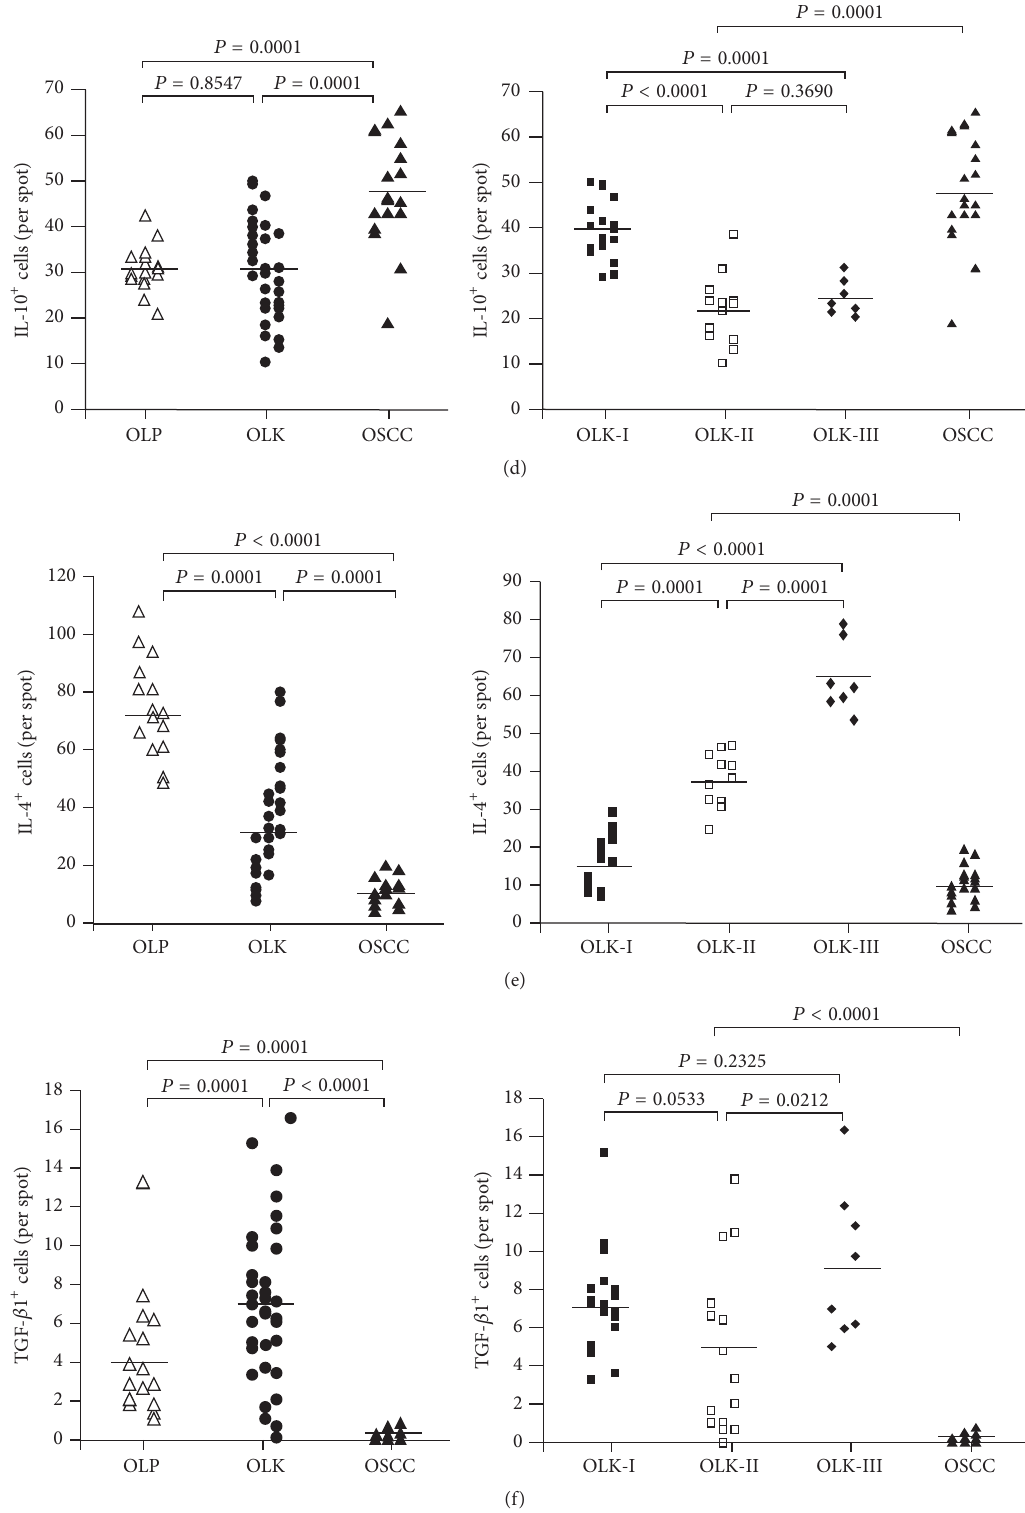
Figure 3: Distribution and frequency of IL-10 + , IL-4 + , and TGF- 𝛽 1 + macrophages in OLP, OLK, and OSCC tissues. (a) IL-10-immunostained sections. (b) IL-4-immunostained sections. (c) TGF- 𝛽 1-immunostained sections. (d) Frequency of IL-10 + macrophages in OLP, OLK-I, OLK- II, OLK-III, and OSCC tissue. (e) Frequency of IL-4 + macrophages in OLP, OLK-I, OLK-II, OLK-III, and OSCC tissue. (f) Frequency of TGF- 𝛽 1 + macrophages in OLP, OLK-I, OLK-II, OLK-III, and OSCC